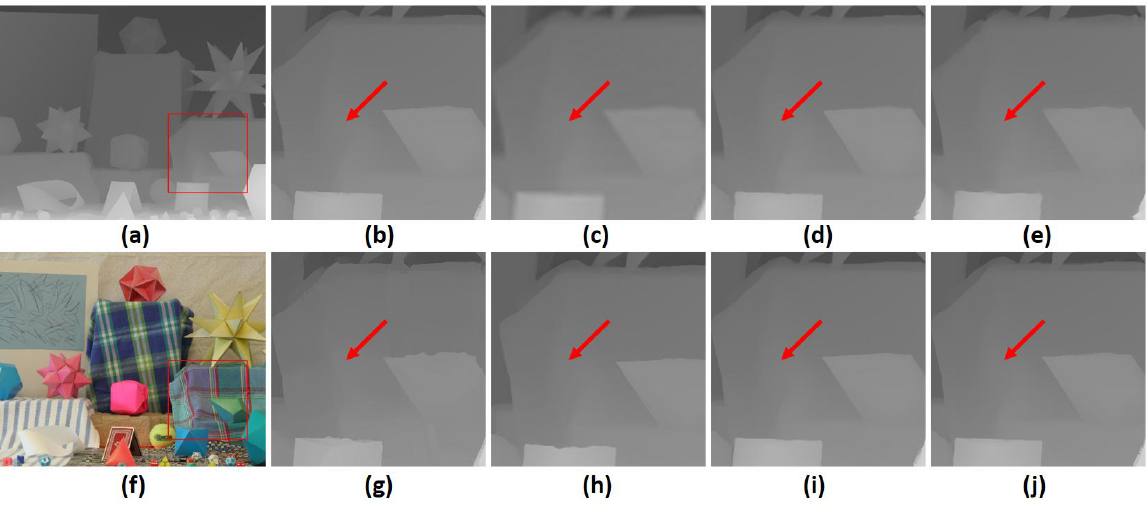
Figure 4. A visual quality comparison for depth map SR at a scale factor of 8 on the noise-free “Moebius” dataset. ( a ) HR depth image, ( f ) HR color image, ( b ) extracted ground truth patch (marked by a red square, and upsampled patches by ( c ) Bicubic, ( d ) MSG [4], ( e ) DSR [3], ( g ) RDGE [32], ( h ) RDN [7], ( i ) CTG [23], ( j ) the proposed FCTN method (best viewed on the enlarged electronic version).